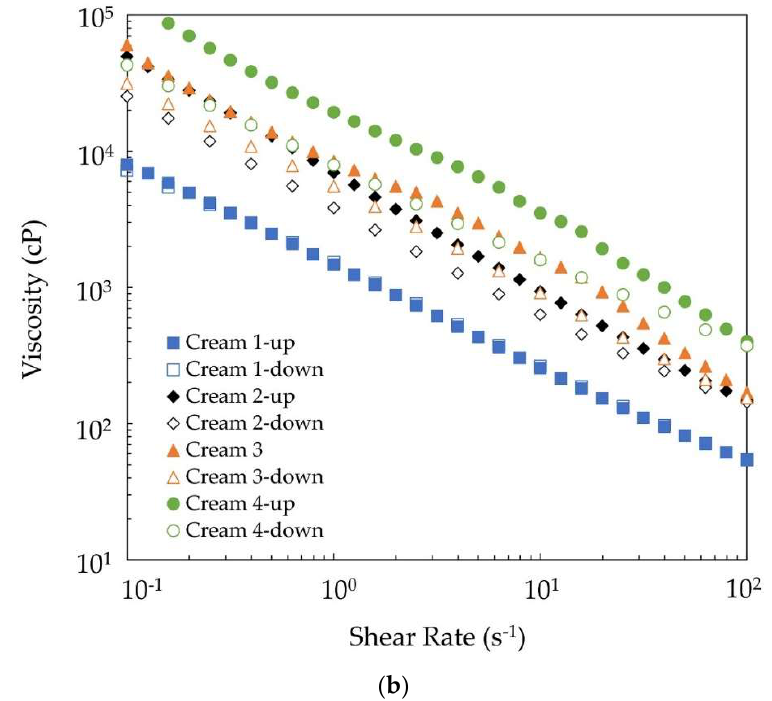
Figure 3. ( a ) Viscosity-shear rate data and power law model fitting for the four creams. ( b ) Viscosity-shear rate data showing the extent of thixotropy in the four creams.